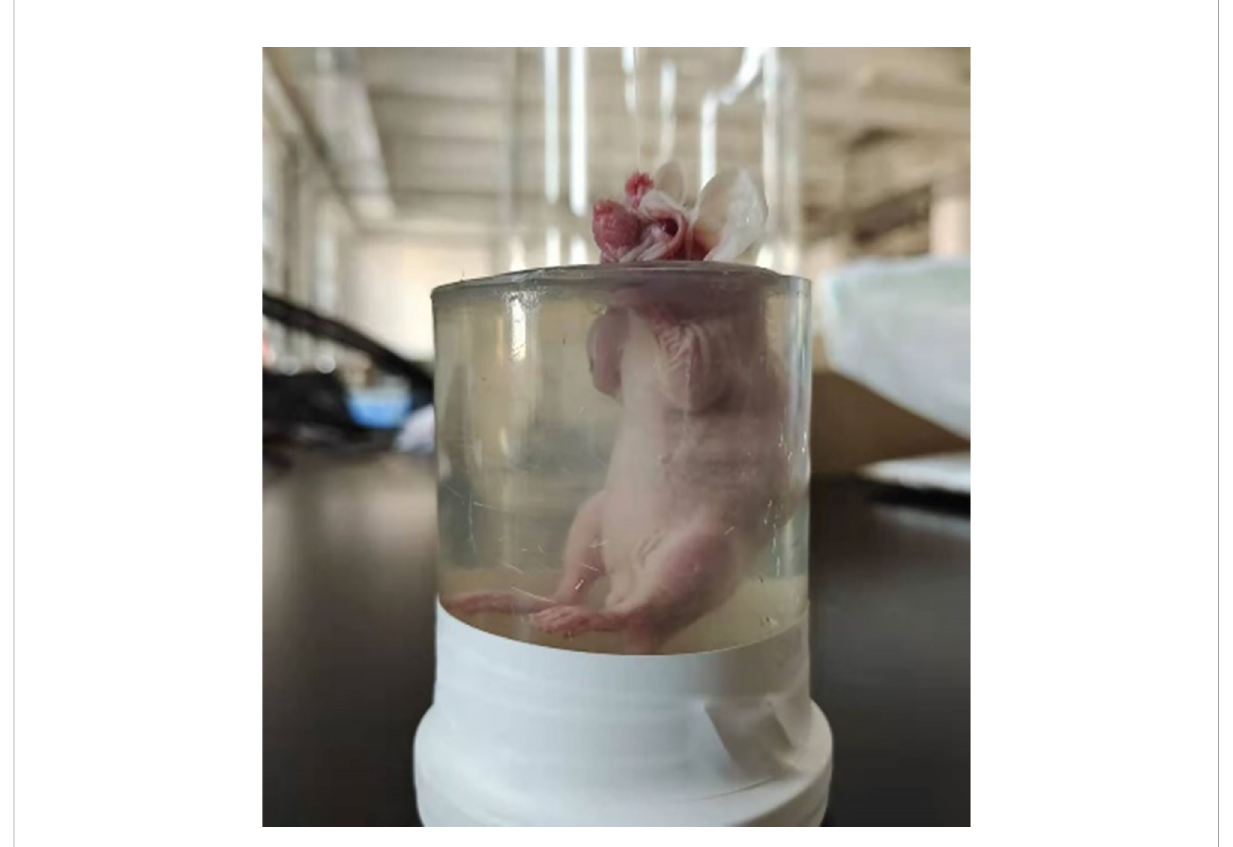
FIGURE 10 The model of mouse for Magnetoacoustic